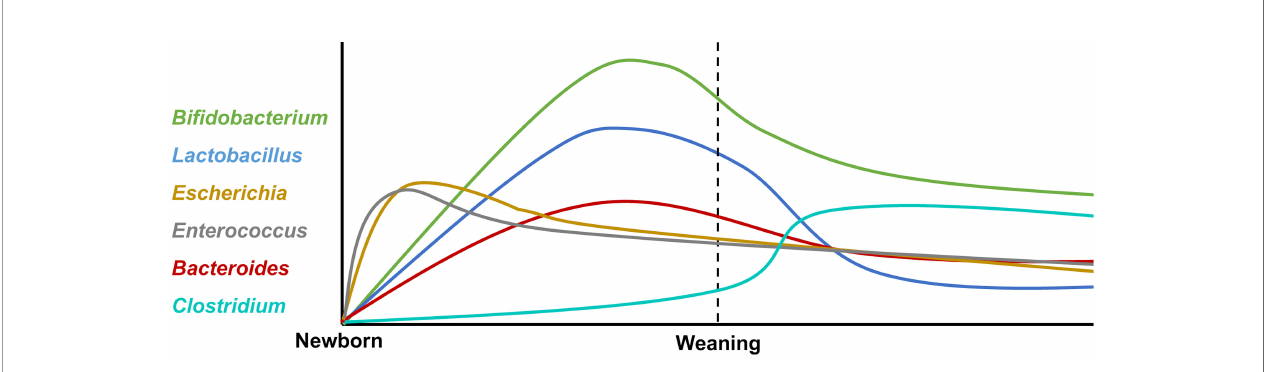
FIGURE 1 | The variation of intestinal core microbiota after birth. The neonatal intestinal microbiota is mainly composed of Bi fi dobacterium , Enterococcus , Lactobacillus , Escherichia , Bacteroides , and Clostridium . After birth, facultative anaerobe bacteria Escherichia and Enterococcus increase rapidly and decrease gradually. The abundance of Bi fi dobacterium , Lactobacillus , and Bacteroides rises at the peak before weaning and then declines by degrees. Clostridium expands rapidly